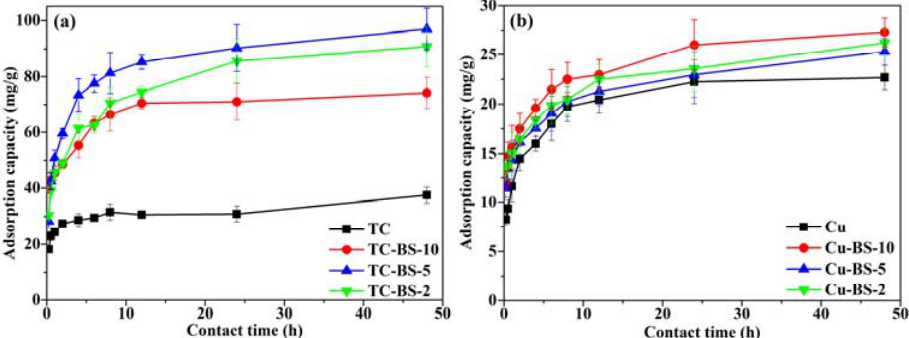
Figure 3. The adsorption performance of A&C500 for ( a ) TC and ( b ) Cu (II) under the single and binary systems as the function of contact time. (Note: the number in BS-10, BS-5 and BS-2 refers to the ratio between target adsorbate and competitive substance in a binary system (i.e., 10:1, 5:1 and 2:1)).